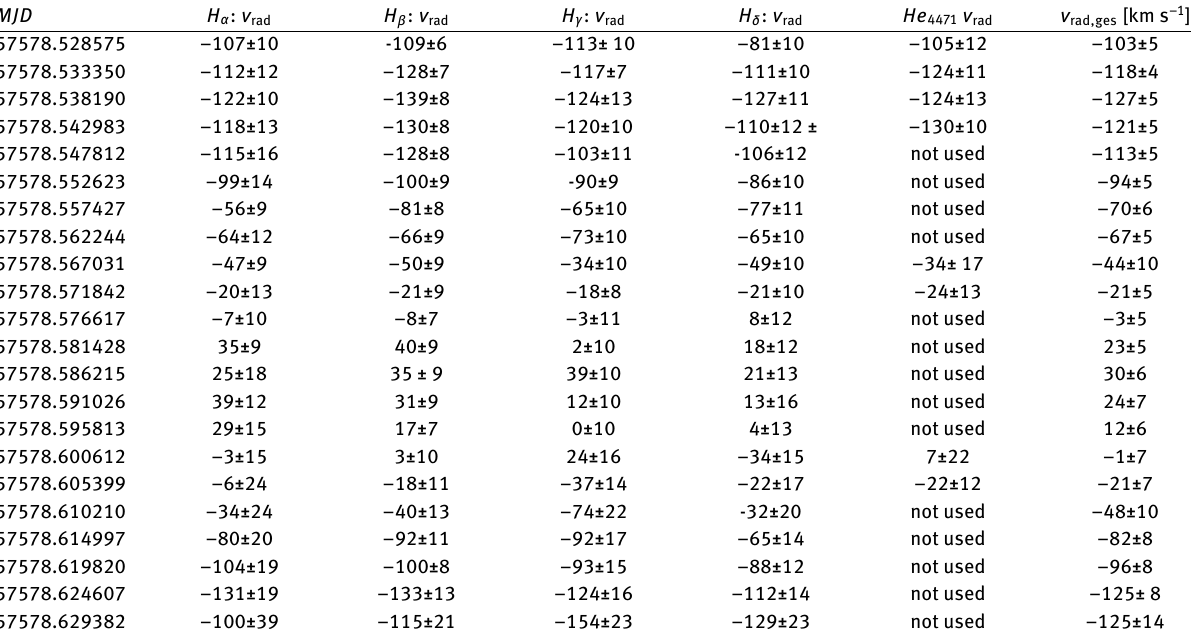
Table 2. Radial velocities from Keck ESI spectra. The last column includes the averaged radial velocity for each spectrum and the corre- sponding errors (errors calculated by Gaussian error